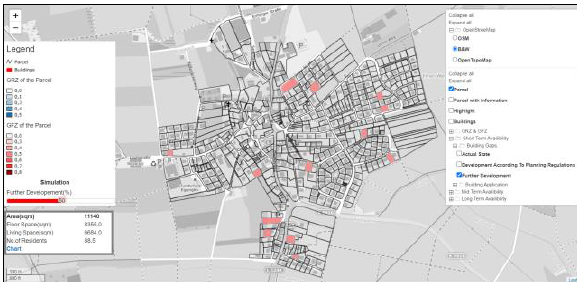
Figure 13 : Simulation of the different potential housing areas Figure 10 : Building Gaps where 50% of the Land Affected Figure 14 depicts that the floor space is higher overall in the will be Further Developed outer potential areas designated in the preparatory land use plan (outer potential area with land use plan) and consequently the living space and the potential number of residents are